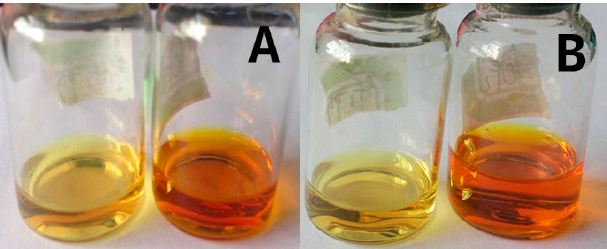
Figure 8. By adding 3 equivalents of metal ions with matter IR1 ( A ), the color change photos of Ir2 ( B ) acetonitrile solution (2.0 × 10 − 5 mol/L) in acetonitrile. (The two figures on the left side show the solution of the coordination compounds with the addition of Hg2 + color, the figures on the right, coordination compound